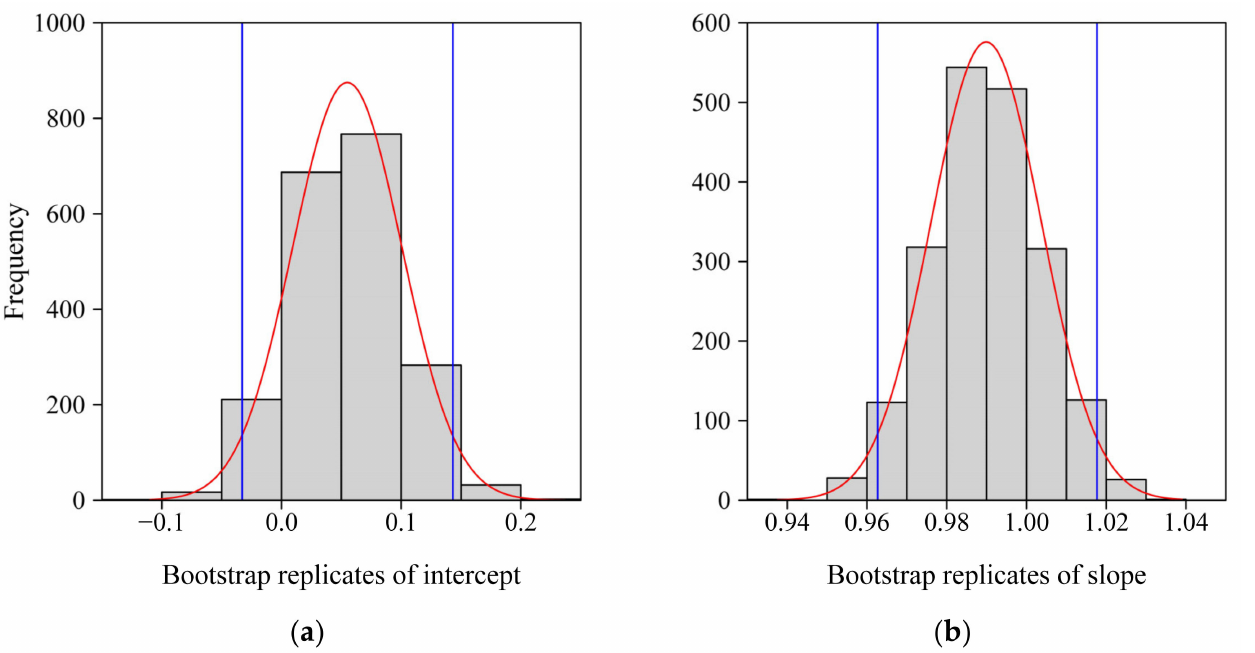
Figure 5. Frequency histograms of bootstrap replicates of the intercept ( a ) and slope ( b ) of the regression between the model parameters n 3 and n 2 (Equation (3); Figure 4). The red curves are normal density curves; and the blue vertical straight lines represent 0.025 quantile (left) and 0.975 quantile (right) that are the lower and upper bounds of the 95% confidence interval in each